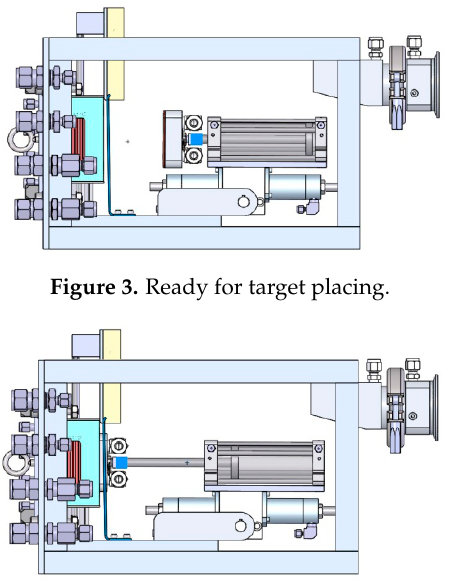
Figure 4. Grabbing the target from the